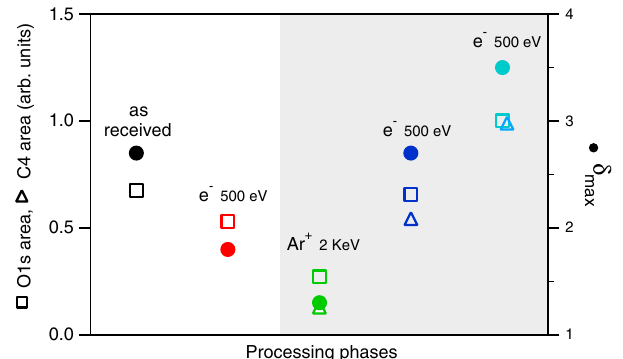
FIG. 7. O1s intensity (squares), Al O (C4) intensity (tri- 2 3 (circles) measured on the Petra III Al sample angle), and (cid:1) max after different surface treatments comprised in two experiments that are the irradiation of the as-received Al alloy (left part) and the irradiation of the sample cleaned by Ar þ sputtering (right part); (black) as-received; (red) e (cid:1) beam, 500 eV, 1 : 2 (cid:3) 10 (cid:1) 1 C = mm 2 ; (green) Ar þ bombardment, 2 KeV; (blue) e (cid:1) beam, 500 eV, 2 : 9 (cid:3) 10 (cid:1) 2 C = mm 2 ; (cyan) e (cid:1) beam, 500 eV, 1 : 4 C = mm 2